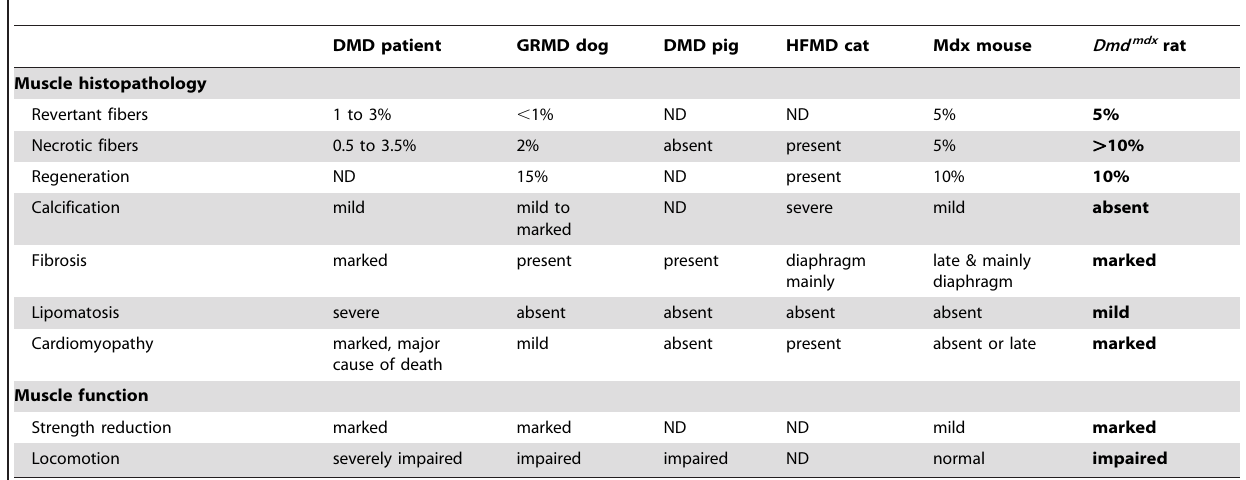
Table 2. Comparison of pathological and functional characteristics between patients and animal models of Duchenne